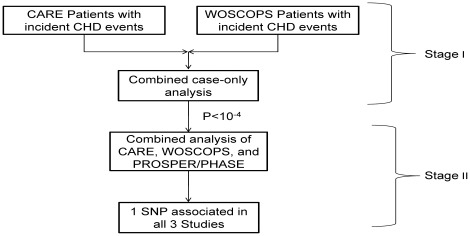
Study design.A flow chart outlining the patients and SNPs investigated in the 2 stages of the study.